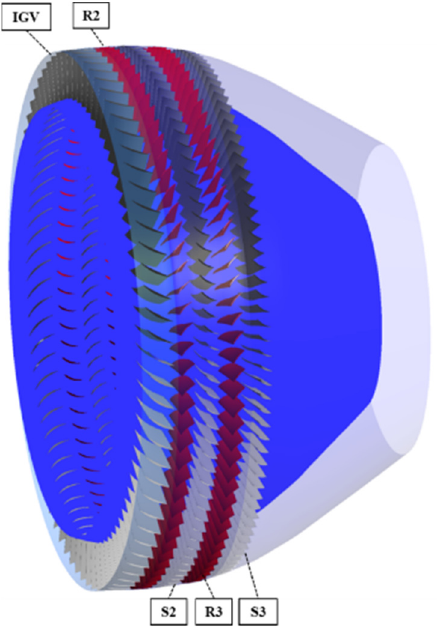
Figure 2. LPC geometry showing inlet guide vanes (IGV) and first two stages of the LPC. Three scenarios regarding LPC degradation over the operational life of the research engine are investigated: uncoated LPC blades with the efficiency decrease of the compressor reaching 3% in the latter life of the engine; coated compressor blades presenting a reduction in the degradation of 25 and 50% by reference to the uncoated variant. These two scenarios are known as Case 1 and Case 2, respectively. The LPC performance deterioration with